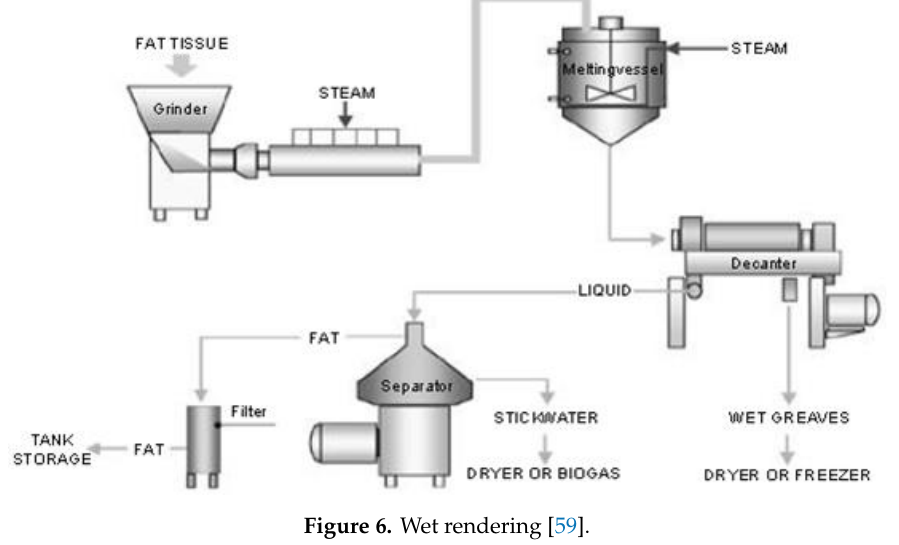
Figure 6. Wet rendering [59]. Figure 6 . Wet rendering [59]. Figure 6 . Wet rendering [59].